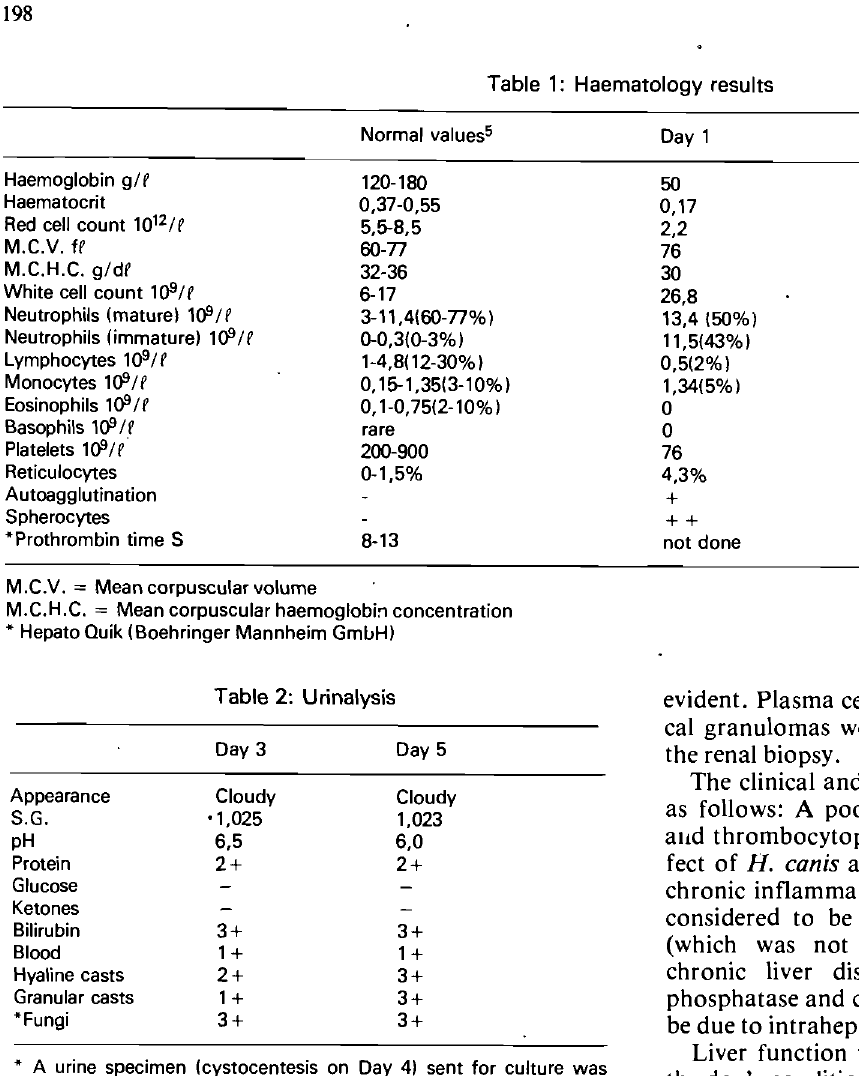
Table 1: Haematology results